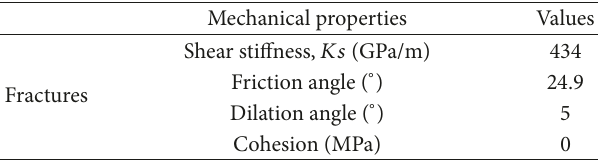
Table 1: Material parameters of the fracture in the calculation